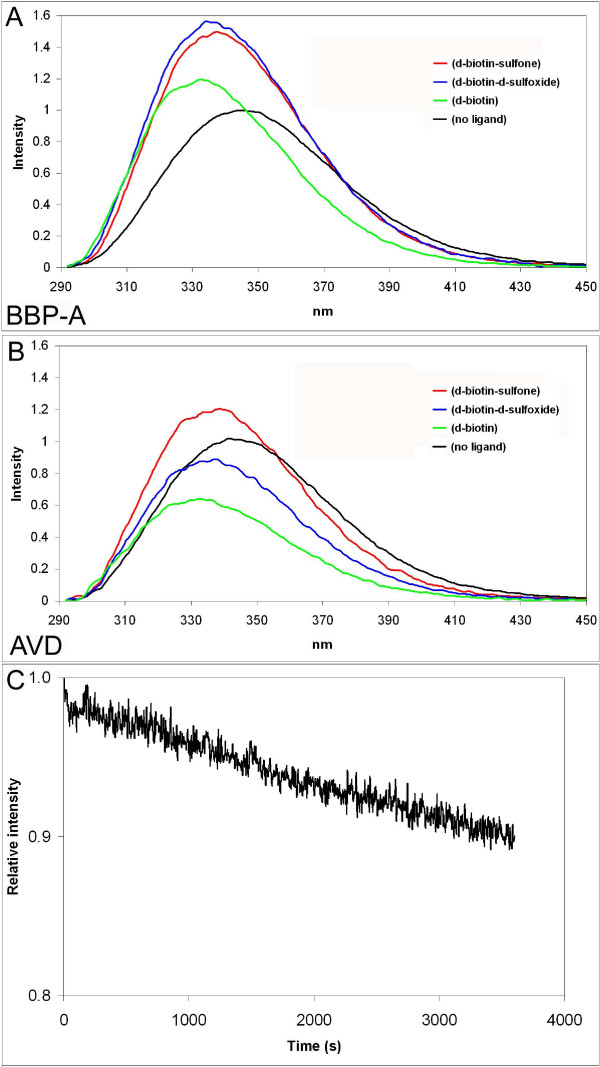
Fluorescence spectroscopy analysis of BBP-A and AVD. (a) Emission spectra of BBP-A in the absence of ligand (black) and with BTN (green), BSO (blue) or D-biotin sulfone (red) are shown. (b) Emission spectra of AVD. (c) Dissociation of D-biotin sulfone from BBP-A displaced with excess of BTN at 40°C. The measured emission intensity is plotted over time and corrected using the emission decay data from control measurements, which were made for protein saturated with BTN. Excitation at 280 nm was used.